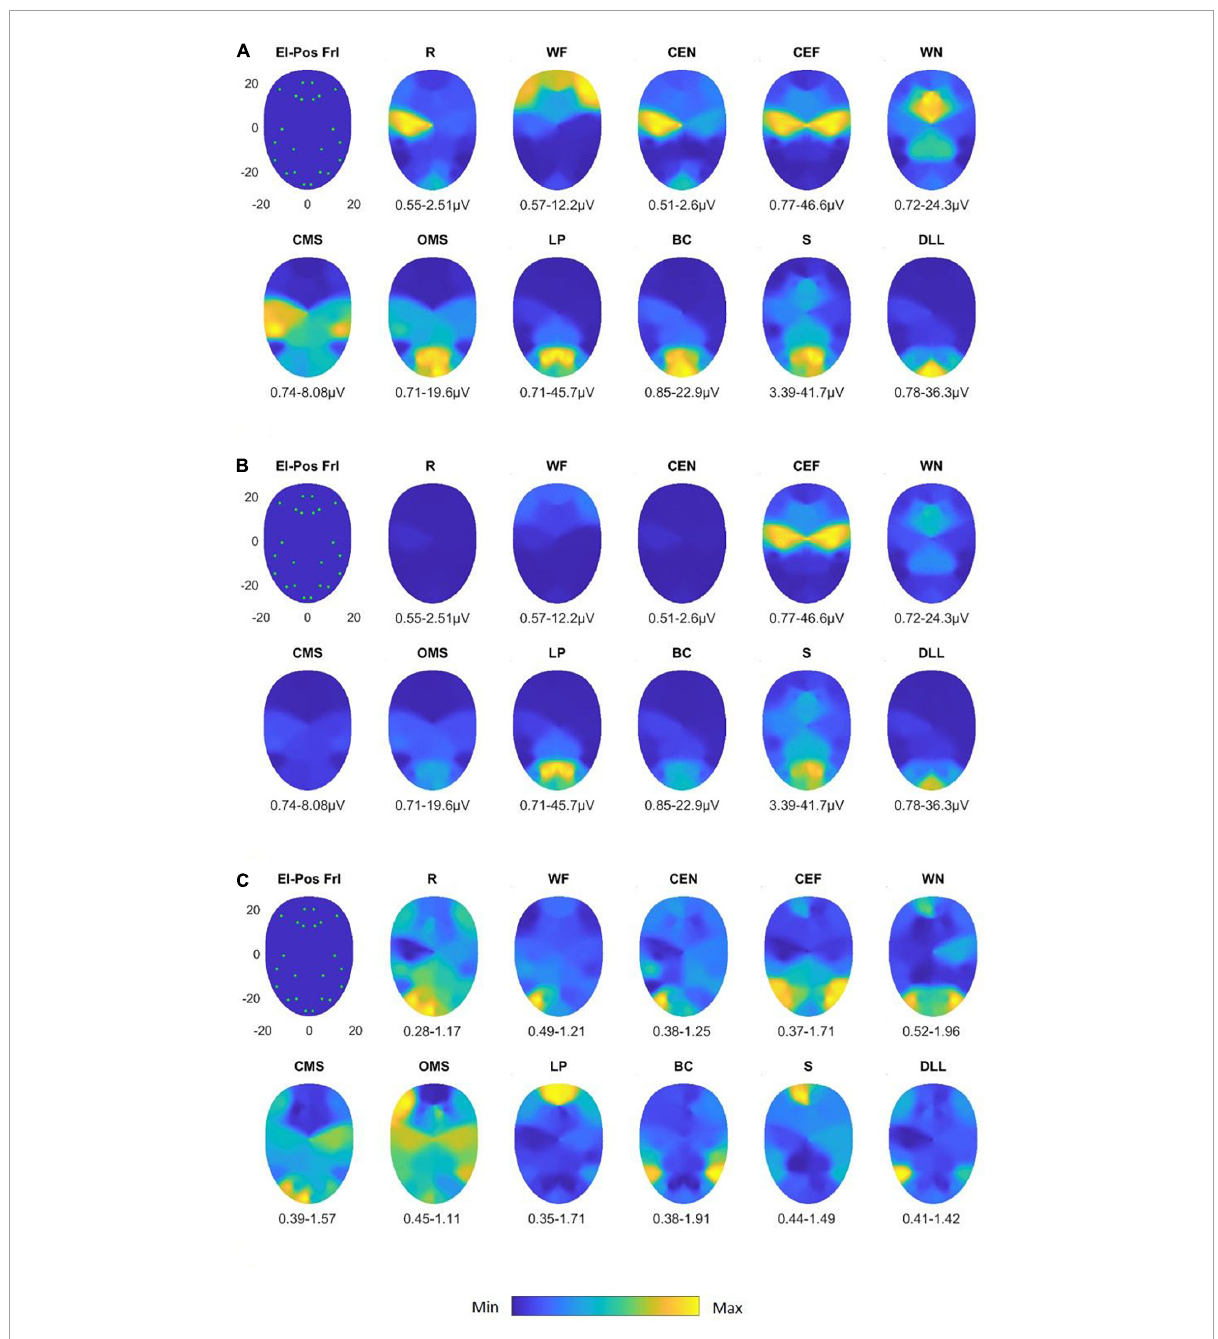
FIGURE3 Activation heat maps of facial muscle activity during different mimic exercises using the Fridlund scheme (El-Pos Fri). According to the provided color bars, blue stands for low values and yellow for high values. Below each map, the respective minimal (Min) and maximal (Max) values are provided. (A) Heat maps with always individual Min to Max scaling; (B) heat maps scaled according to the Min and Max values across all facial movements. (C) Variability (variation coefficient) heat maps. R, at rest; WF, wrinkling of the forehead; CEF, closing the eyes normally; CEF, closing the eyes forcefully; WN, wrinkling of the nose; CMS, closed mouth smiling; OMS, open mouth smiling; LP, lip puckering; BC, blowing-out the cheeks; S, snarling; DLL, depressing lower lip.